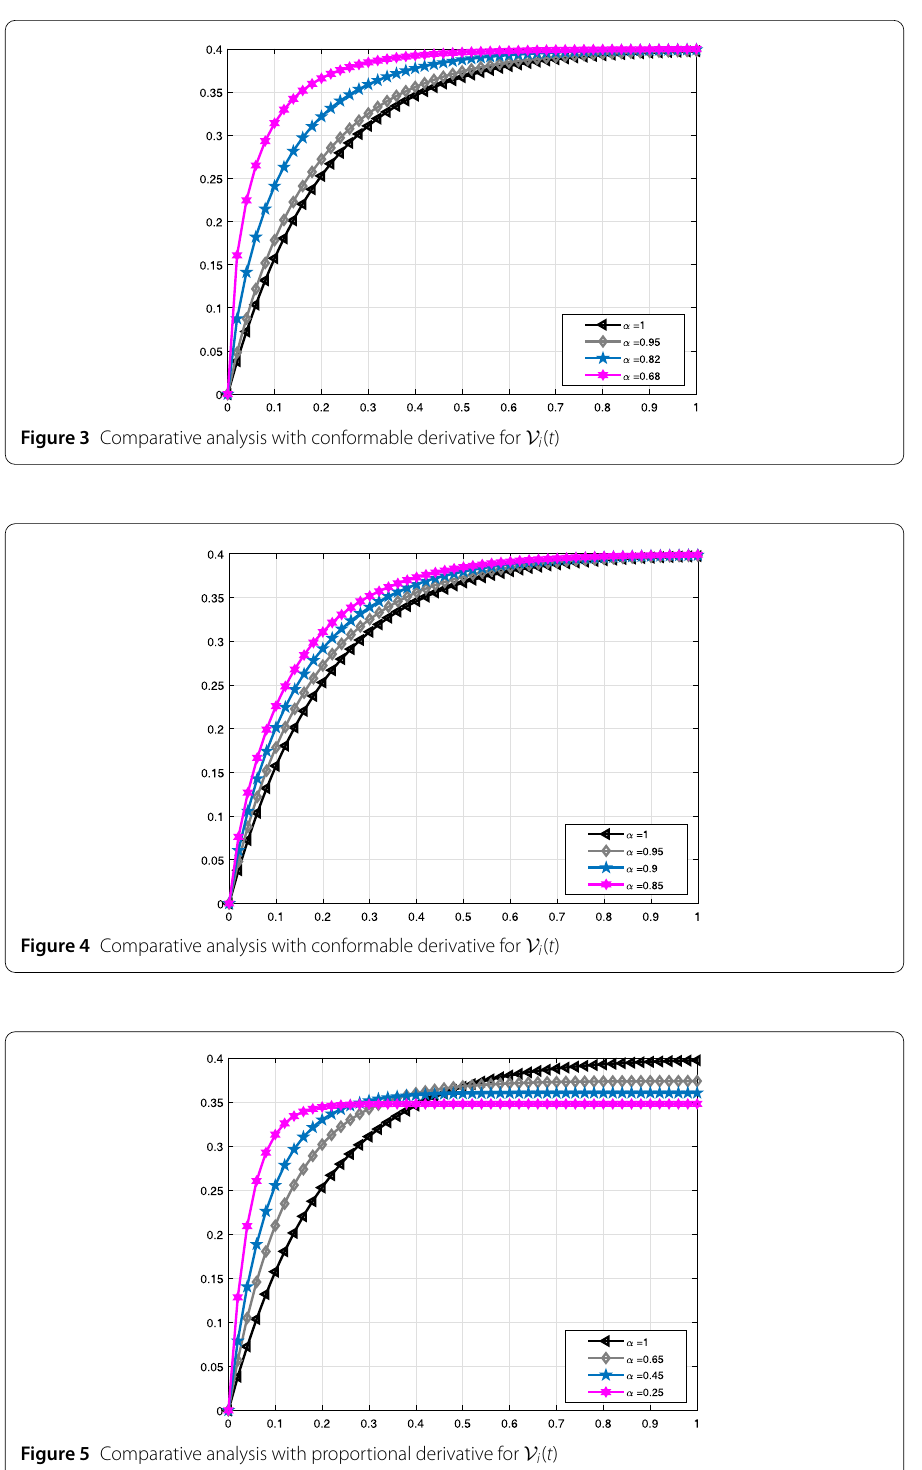
β = 0.5 and α = 0.9 , β = 0.8 , respectively. We can clearly seen that the proportional derivative tends to be close to the classical derivative faster than the truncated M -derivative and conformable